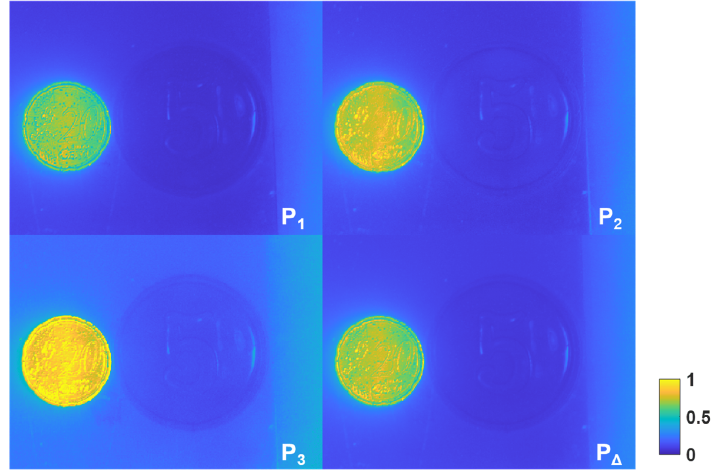
Figure 4. Images related to IPPs and P ∆